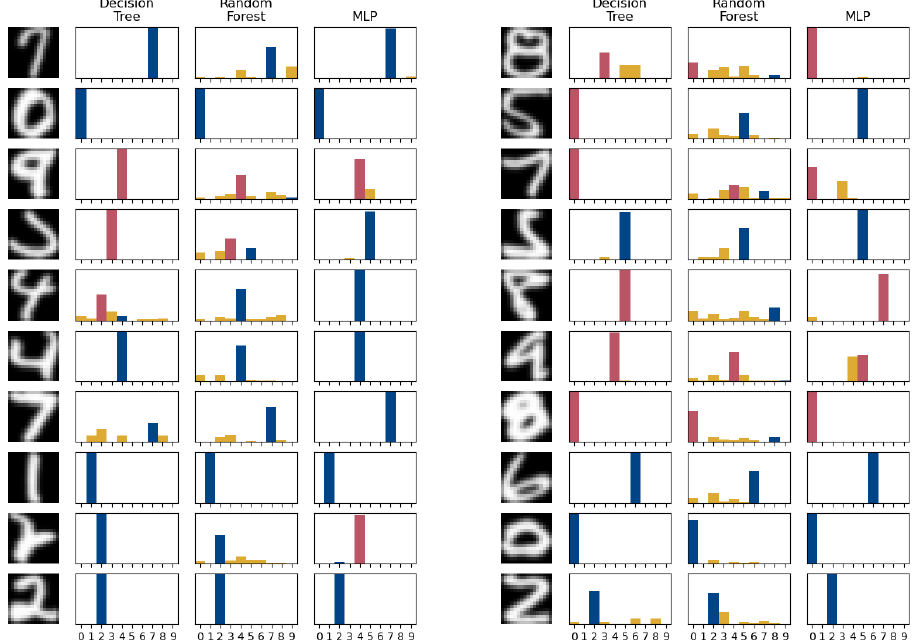
Figure 19. Criticisms of Q b from the dataset X b , with class probabilities under three algorithms trained on X a . The true class is shown in blue ; where the highest probability class differs from the true class, the highest probability class is shown in red